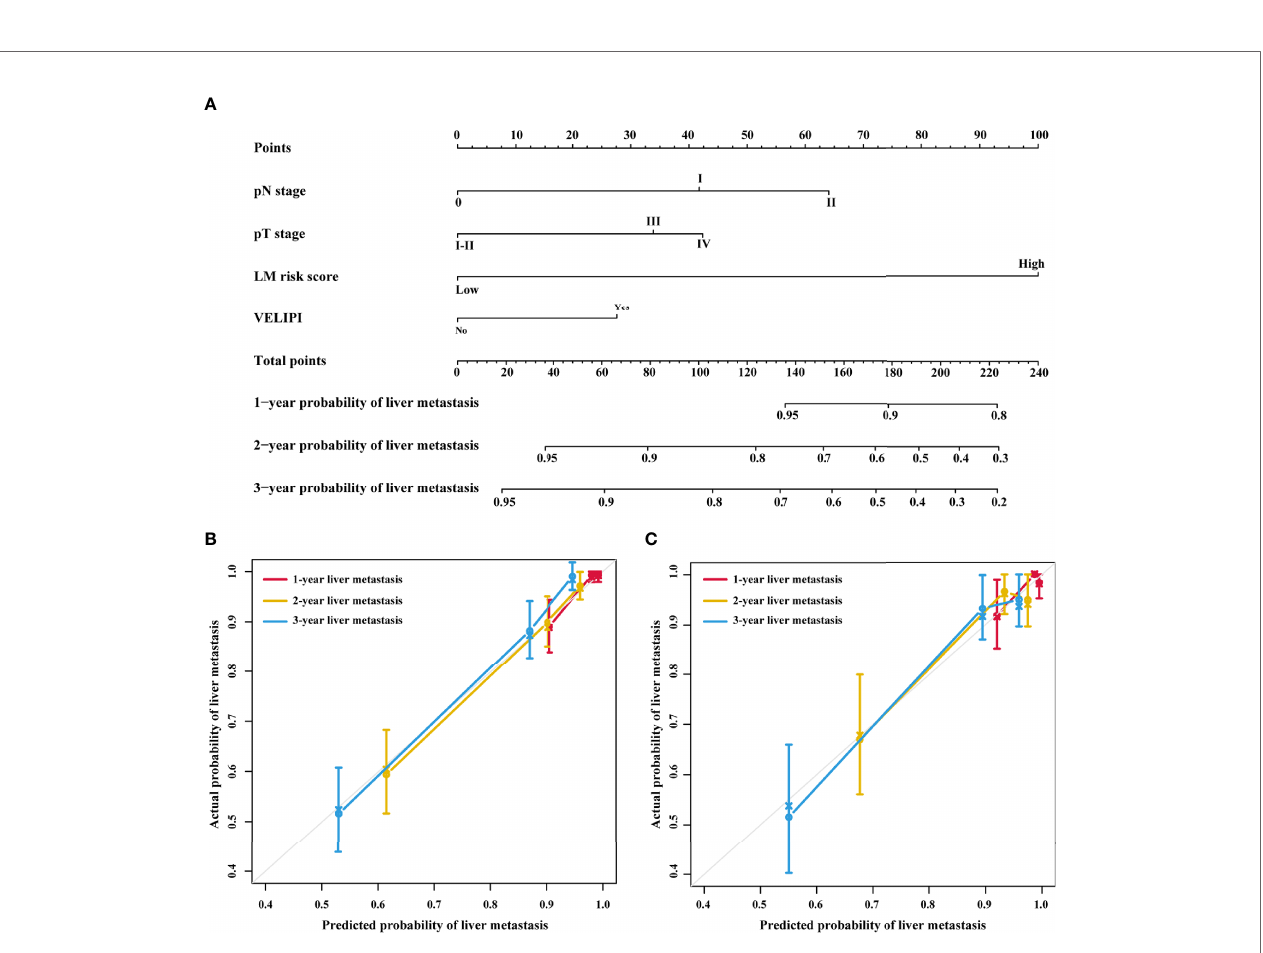
FIGURE 7 | Integrated nomogram and the corresponding calibration curves. (A) Nomogram integrating the LM risk score, pT stage, pN stage and VELIPI for predicting LM. (B) Calibration curve of the integrated nomogram in the training cohort. (C) Calibration curve of the integrated nomogram in the validation cohort. VELIPI, vascular emboli or lymphatic invasion or perineurial invasion; LM, liver metastasis.